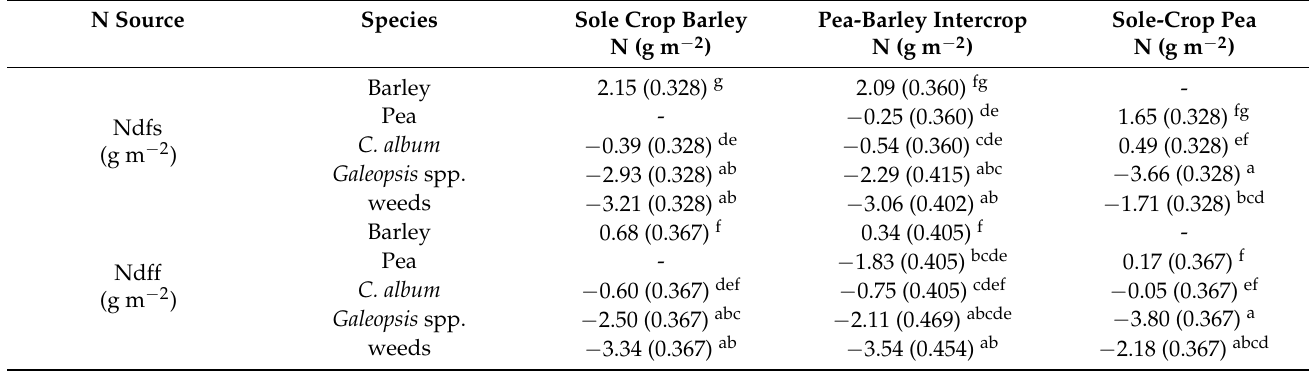
Table A5. Estimates of ln-transformed average accumulated N derived from the soil (Ndfs) and fertilizer (Ndff) in the fertilized treatments of crops separated by species. The presented values correspond to the back-transformed medians presented in Table A4. Values presented in parenthesis are standard errors. Mean values of Ndfs and Ndff are averaged over sampling time (flowering, maturity; thereby n = 6) due to non-significance of this factor in the analysis of variance. Mean values of Ndfa are averaged over the factor N-level ( n = 6). Different letters within each group of N sources indicate significant different mean values following pairwise comparison with Tukey adjustment ( α = 0.05).